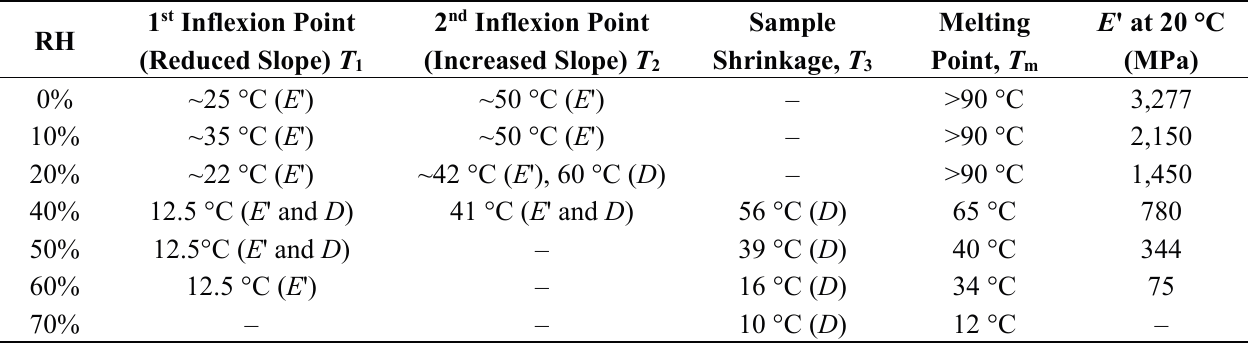
Table 1. Transition temperatures of CaCas/Gly films during isohume T -ramps at 0%–70% RH. Data extracted from the E ' curves ( E ') or D curves ( D ) of Figure